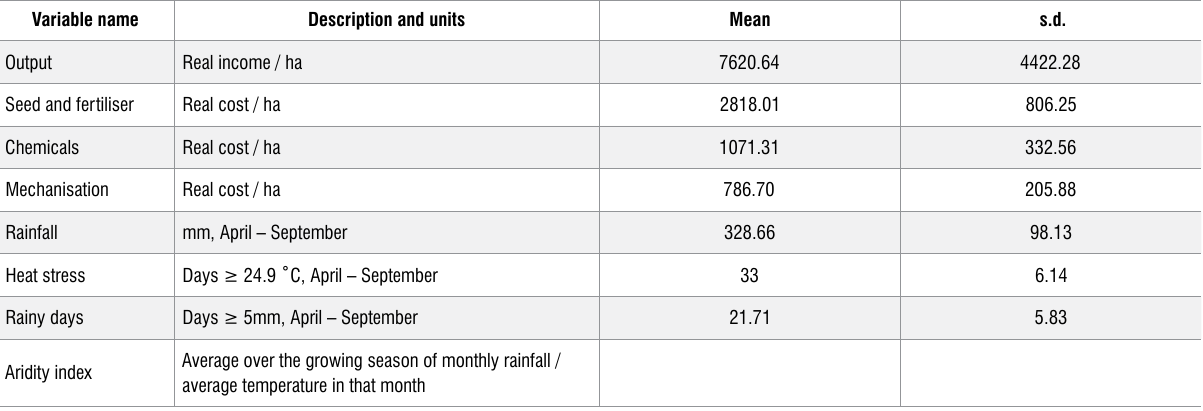
Table 1: Descriptive statistics for the pooled sample of 28 plots over 14 years ( n